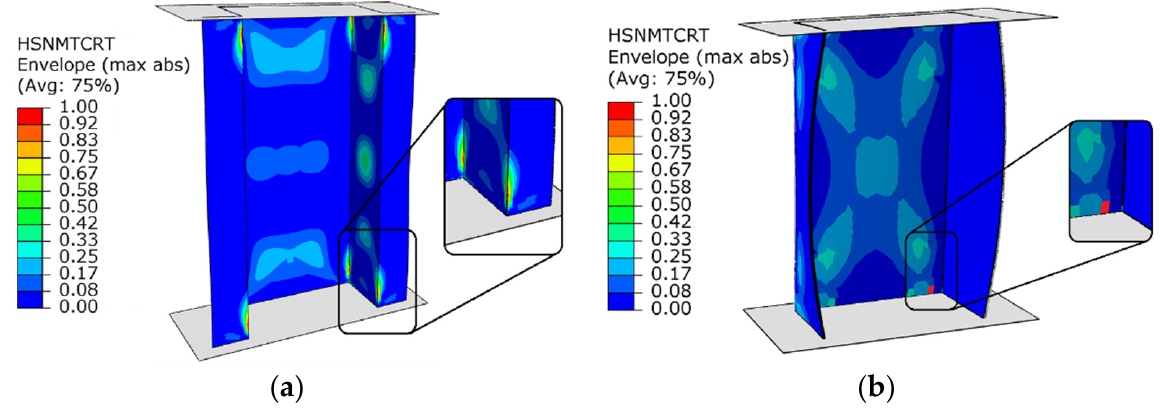
Figure 6. Damage initiation (Hashin criterion—PFA model): ( a ) top-hat column, ( b ) channel column.